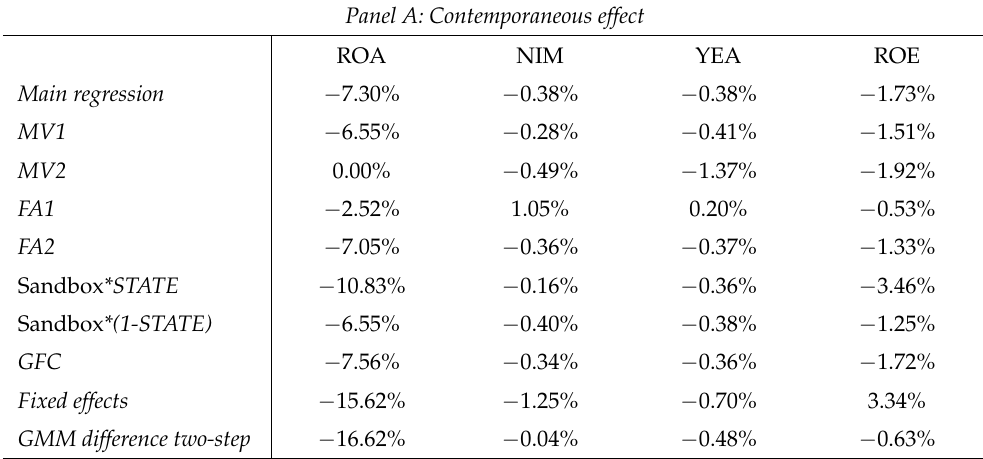
Table 10. Economic